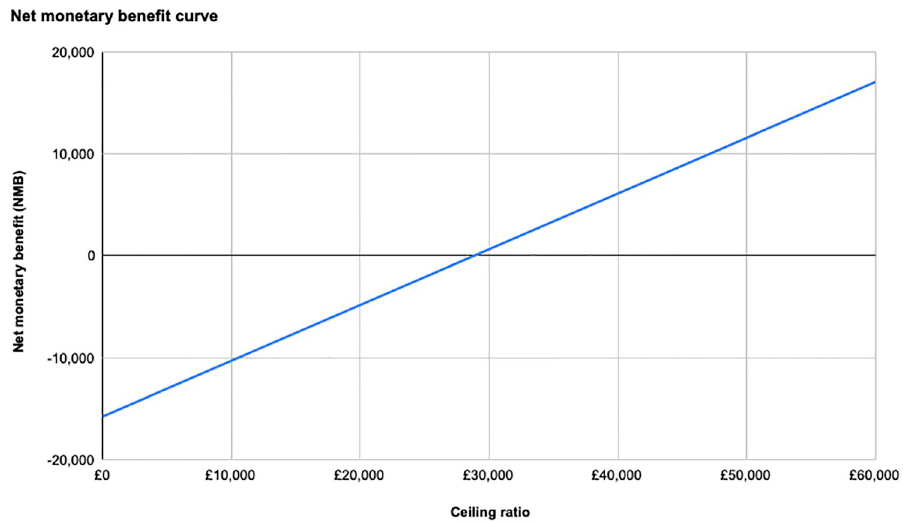
Fig 3. NMB curve of RARC compared to the ceiling ratio.